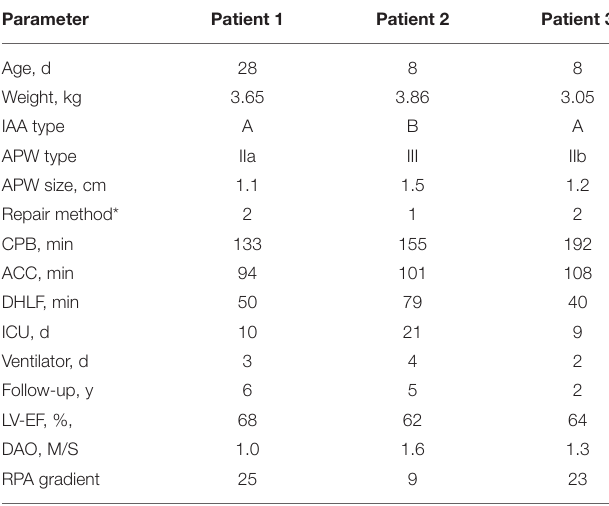
the left common carotid artery and the left subclavian artery (7);